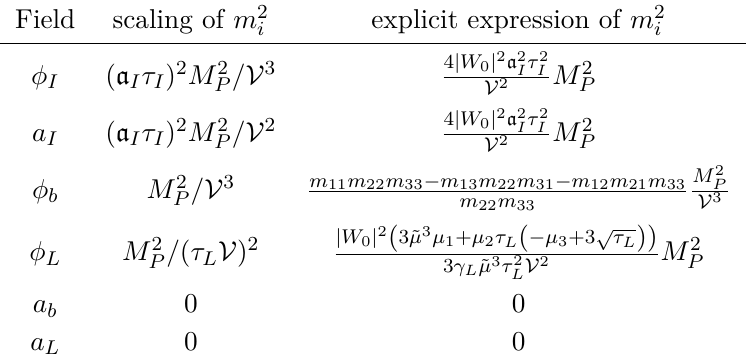
Table 1 . Mass squareds of canonical moduli and axion fields. The parameters ˜ µ and m ij are defined below (D.8) and in (D.12) −